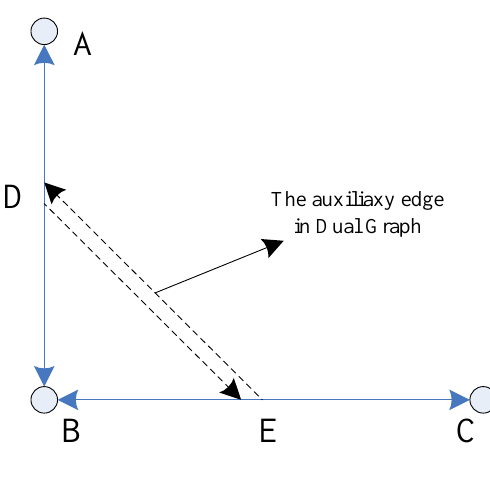
Figure 1. Model of the dual